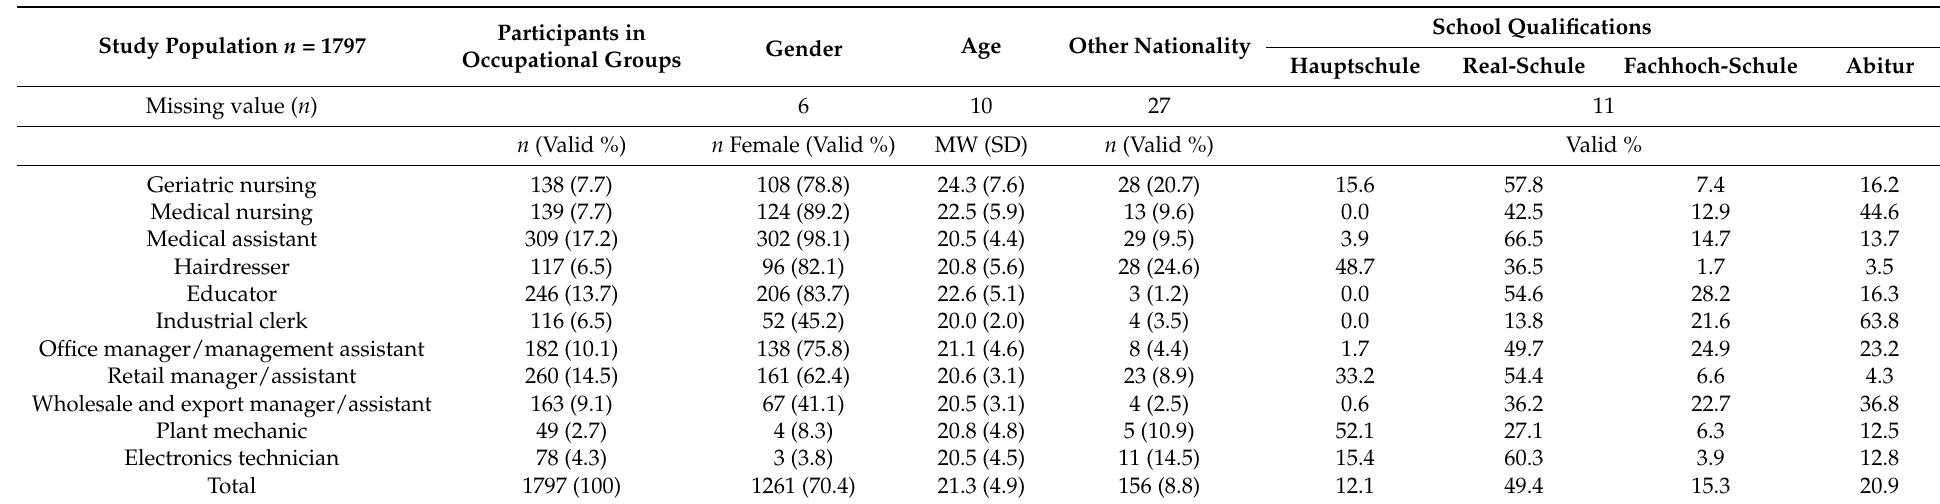
Table 1. Sociodemographic properties of study